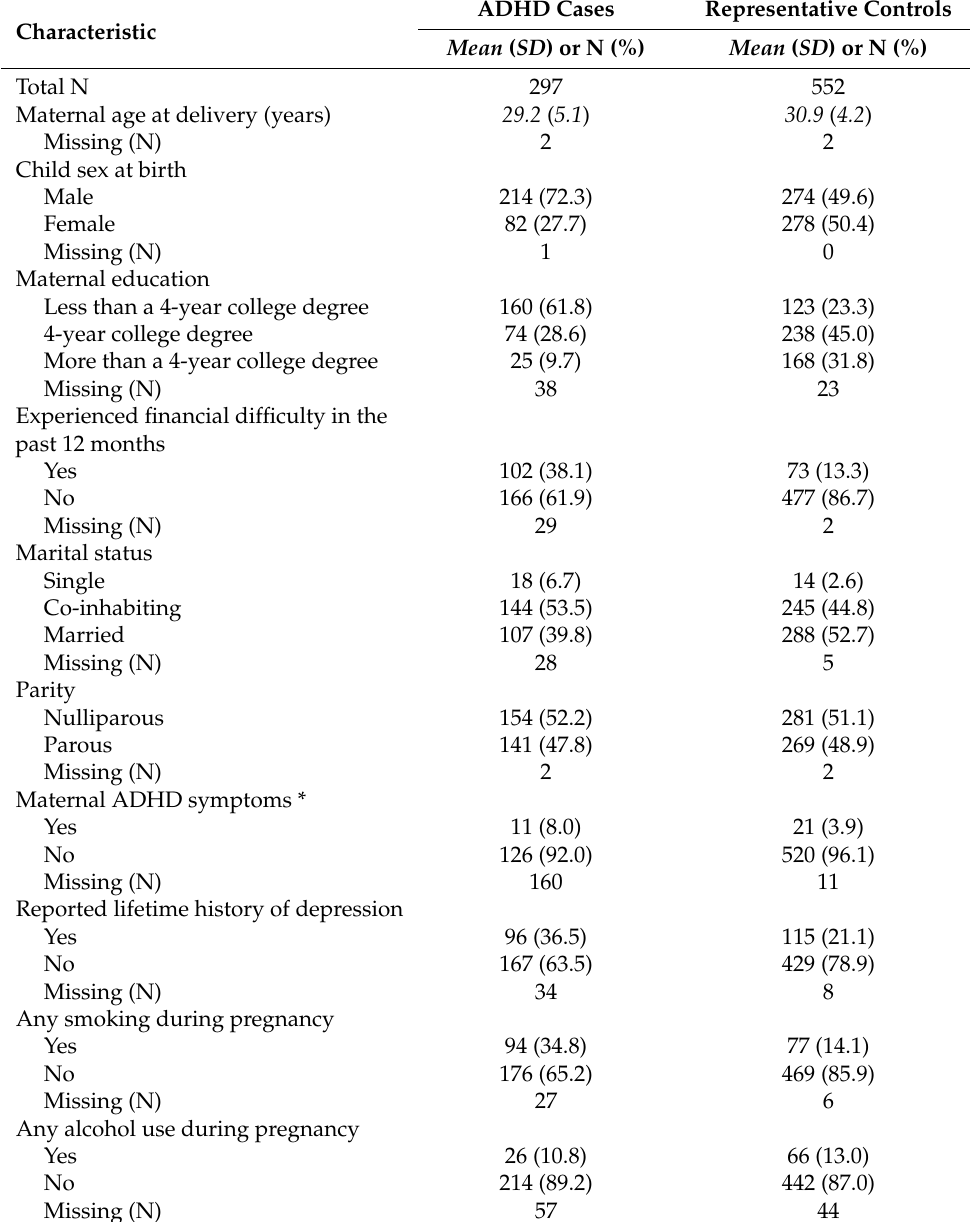
Table 1. Characteristics of a nested case-control study of attention-deficit/hyperactivity disorder (ADHD) in the Norwegian Mother, Father, and Child Cohort Study, birth years